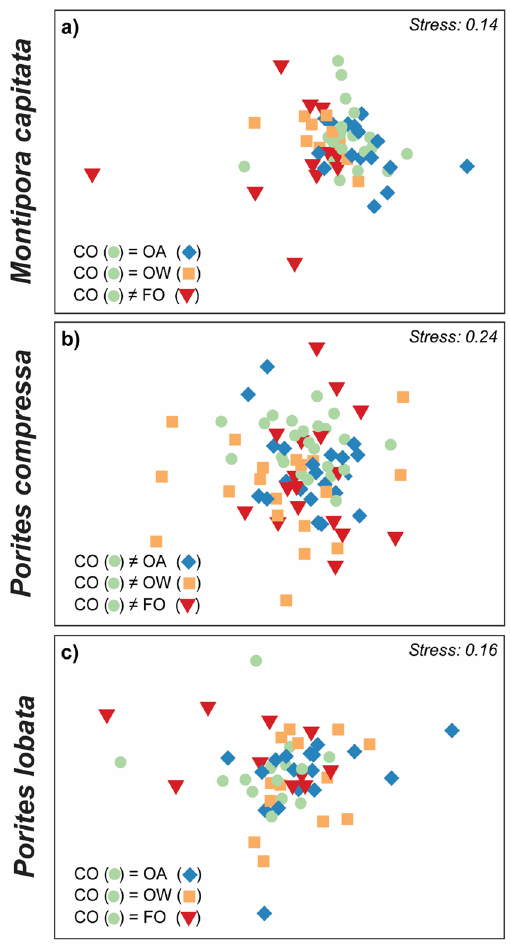
Figure 5. Nonparametric multidimensional scaling plots (NMDS) of coral physiological profiles for ( a ) Montipora capitata , ( b ) Porites compressa , and ( c ) Porites lobata . Data colors correspond to treatments: controls (CO, green circles), ocean acidification (OA, blue diamonds), ocean warming (OW, orange squares), or combined future ocean (FO, red triangles) treatments. Summary of pairwise PERMANOVA tests between CO and each of the treatments is shown in the bottom left of each panel. Additional statistical details in Table